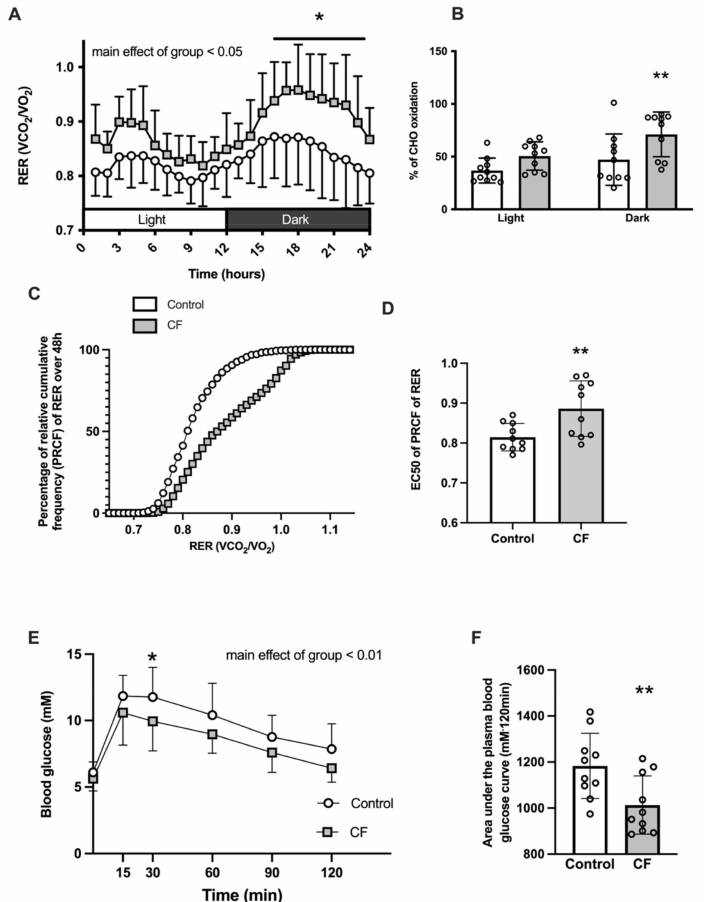
Figure 2. Fifteen days of CF supplementation modified whole-body metabolism in 129S1/SvlmJ mice. ( A ) Respiratory exchange ratio (RER) over the 24 h cycle. ( B ) Carbohydrate and fat oxidation in light and dark cycles. ( C ) Percent relative cumulative frequency (PCRF) of RER. ( D ) Fiftieth percentile values (EC50) of PCRF of RER ( E ) OGTT after an overnight fasting. ( F ) Area under the curve of the OGTT. n = 10–14, means ± SD. * p < 0.05 vs. the control group, ** p < 0.01 vs. the control